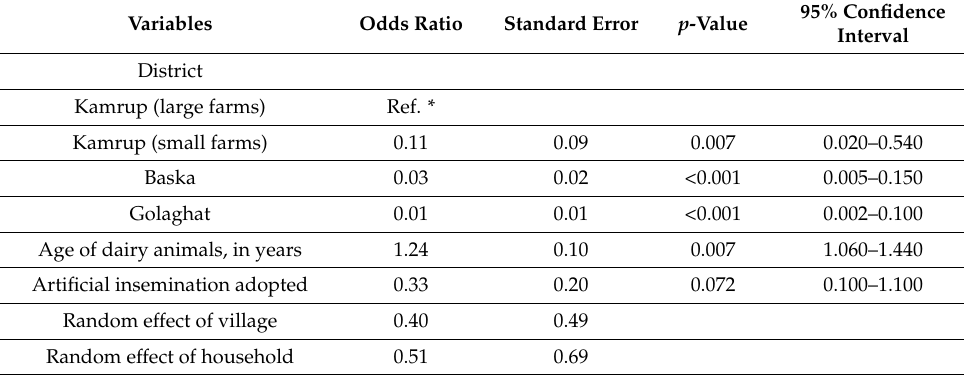
Table 5. Models with the identified risk factors from all sub-group